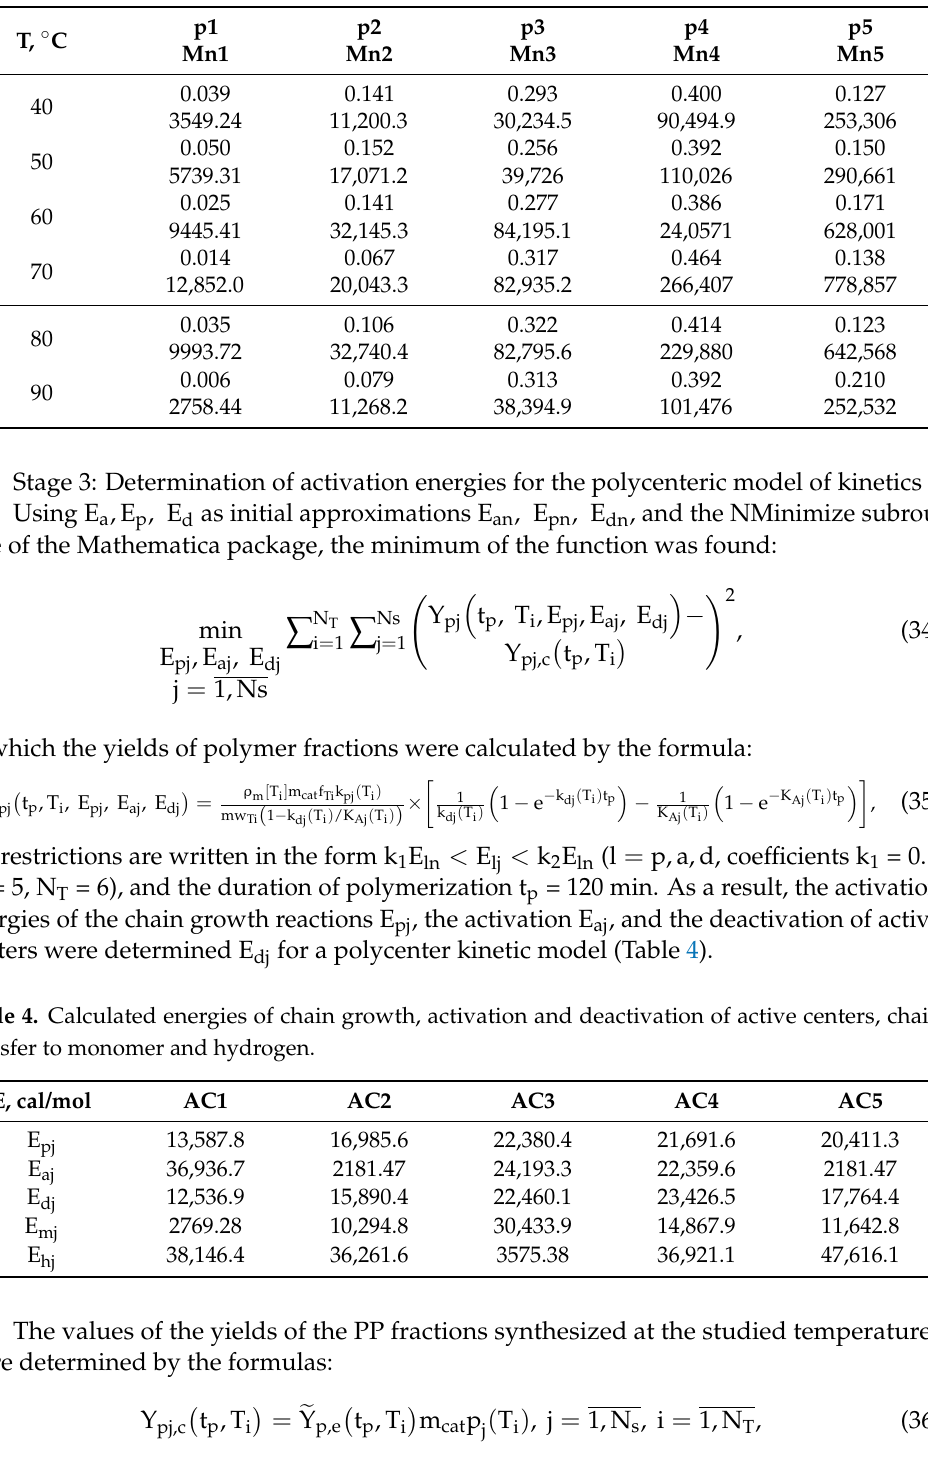
Table 3. Mass fractions and average calculated molecular weights of polymer fractions determined by the MWD deconvolution of PP samples synthesized at the temperatures of T = 40–90 ◦ C (polymer- ization conditions in Table 2).